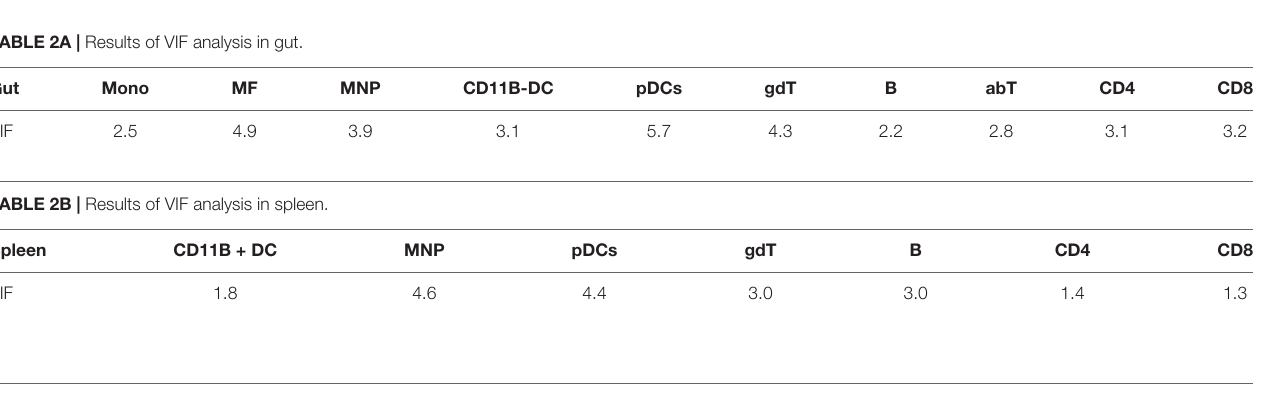
FIGURE 3 | Immune cells changes in the spleen induced of periodontitis microbiota colonization. (A) Heatmap of 15 immune cells in the spleen. (B) Representative flow cytometry dot plots of immune cells with a significant difference. (C) Histogram of immune cells with a significant difference. Data were calculated as means ± SEM. Unpaired Student’s t -test were performed on all the data. Significant results when: * p < 0.05; ** p < 0.01.